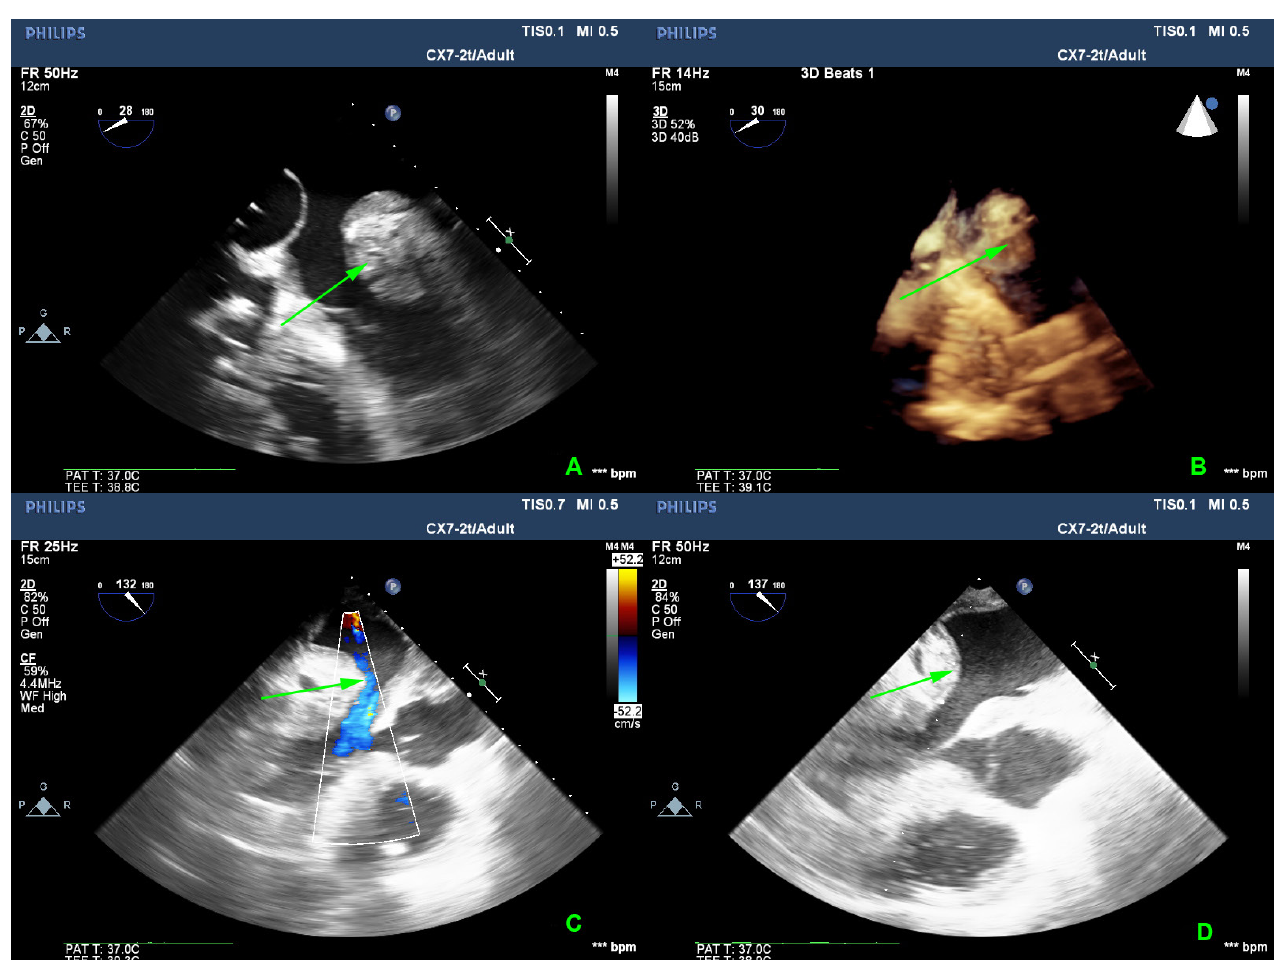
Fig. 1 – (A) Intraoperative echocardiogram showing left atrial dissection; (B) 3D echocardiography; (C) Intraoperative Doppler echocardiography; (D) Early postoperative echocardiogram after the